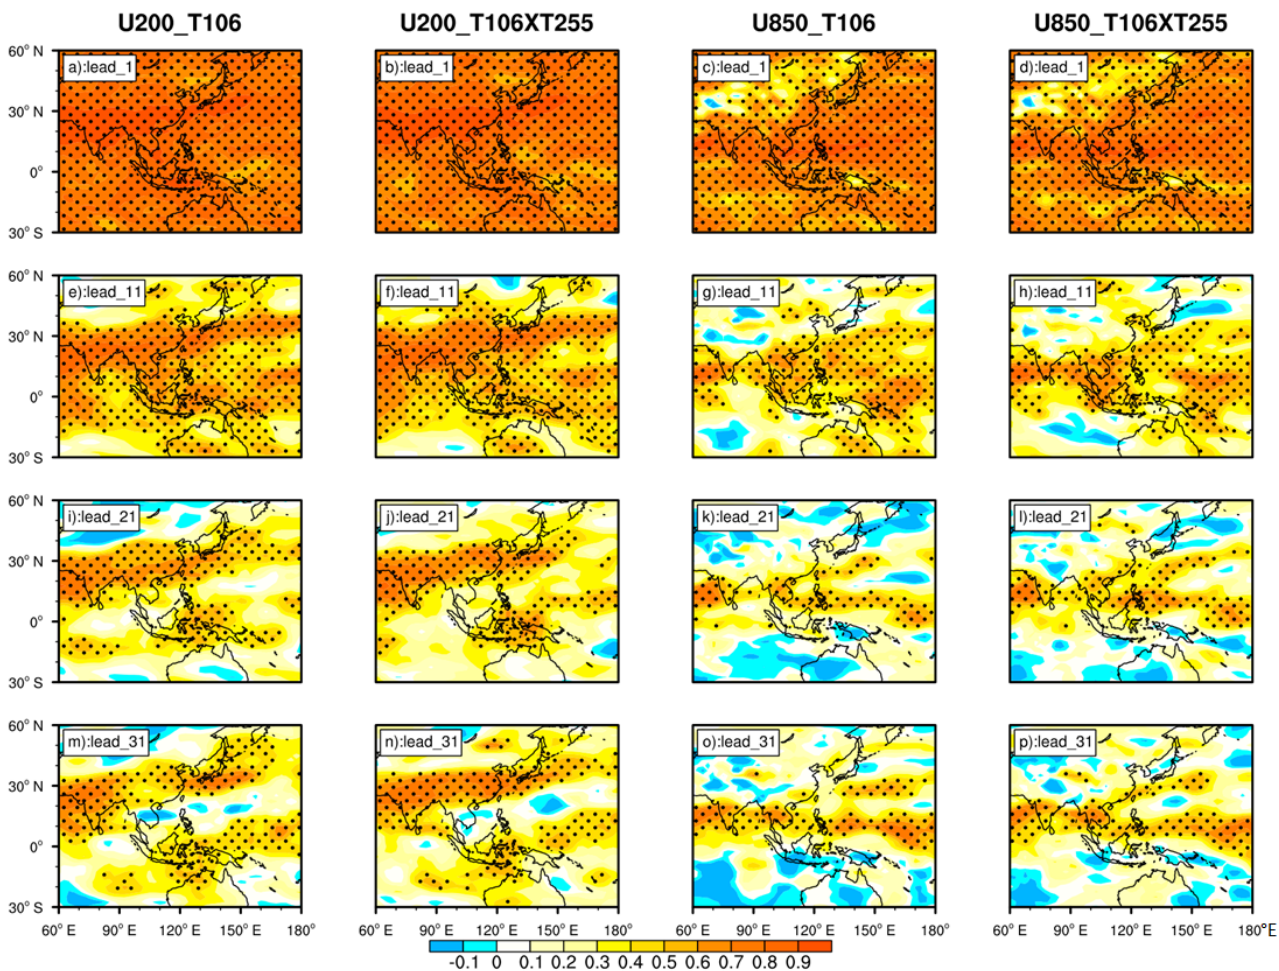
Figure 2. The TCC distribution (shading) of 200 hPa and 850 hPa zonal wind field between prediction results (T106 and T106 × T255) and reanalysis for different lead times. The values exceeding 95% confidence level according to Student’s t -test are dotted. ( a , e , i , m ): 200 hPa zonal wind in T106; ( b , f , j , n ): 200 hPa zonal wind in T106 × T255; ( c , g , k , o ): 850 hPa zonal wind in T106; and ( d , h , l , p ): 850 hPa zonal wind in T106 ×